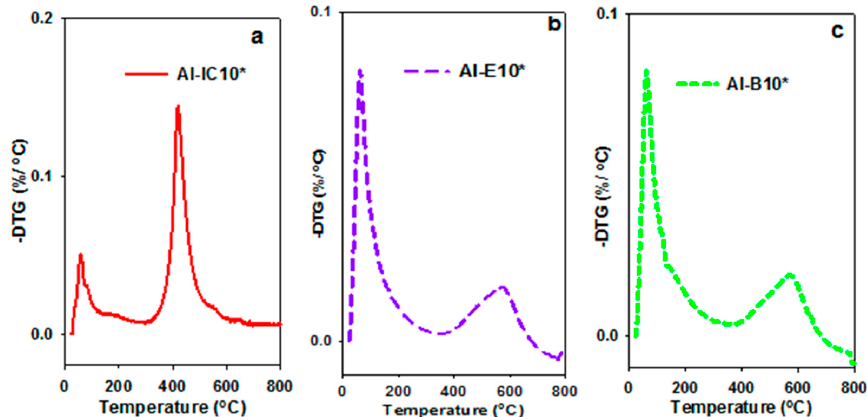
Figure 3. DTG profiles for the extracted and calcined (*) alumina–silica composites containing